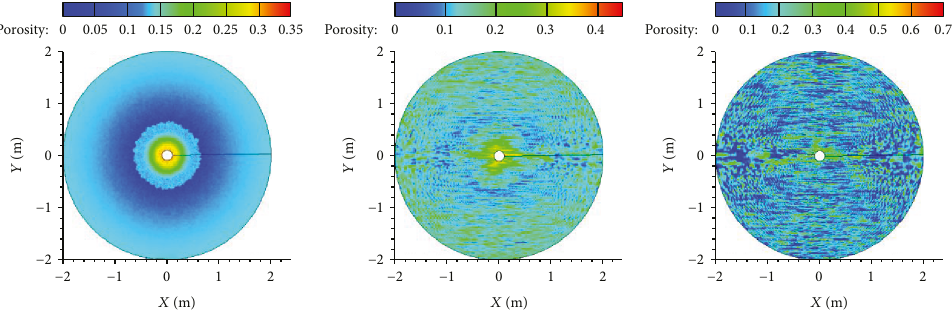
Figure 18: Porosity distribution after acidizing in two layers.